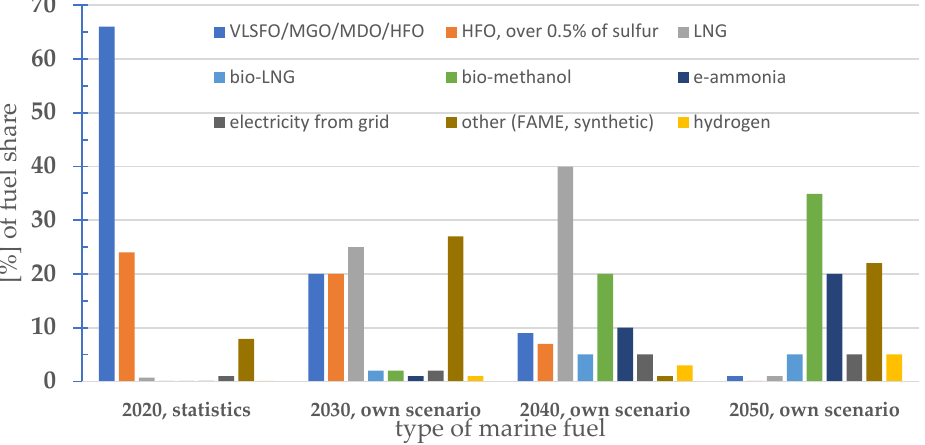
Figure 4. Statistics from 2020 and possible scenarios for the distribution of different marine fuel types to the shipping market by 2050.